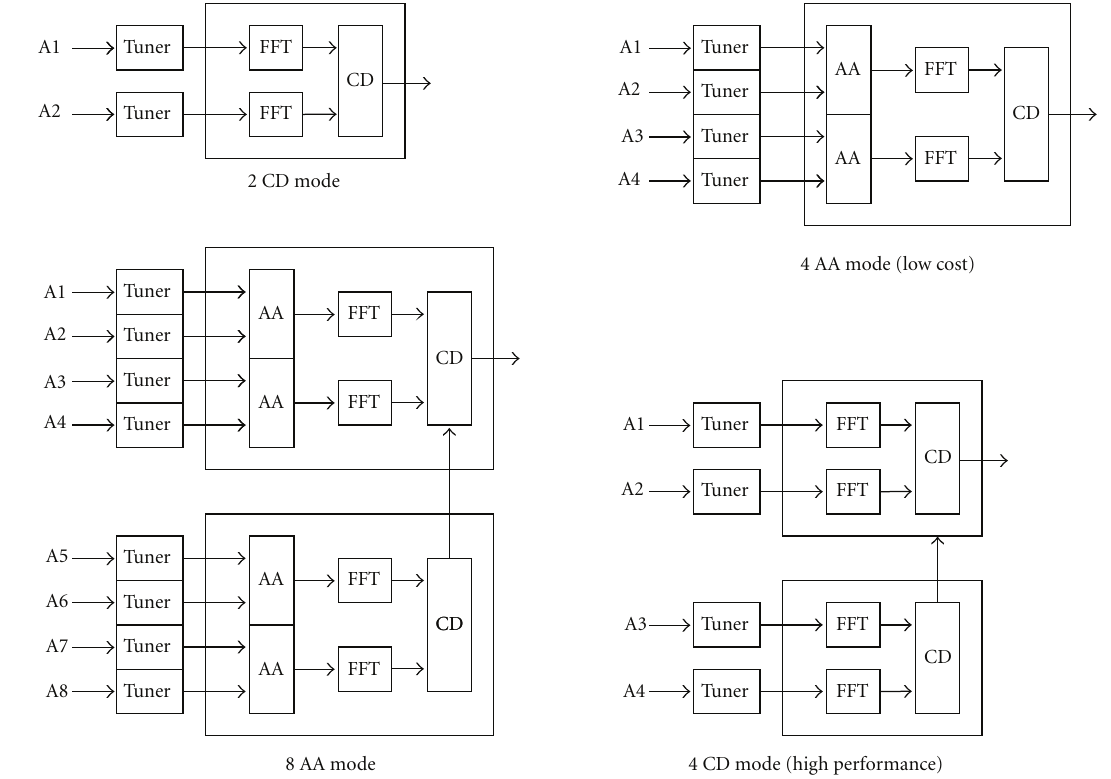
Figure 7: 2/4/8 antennas system configurations.